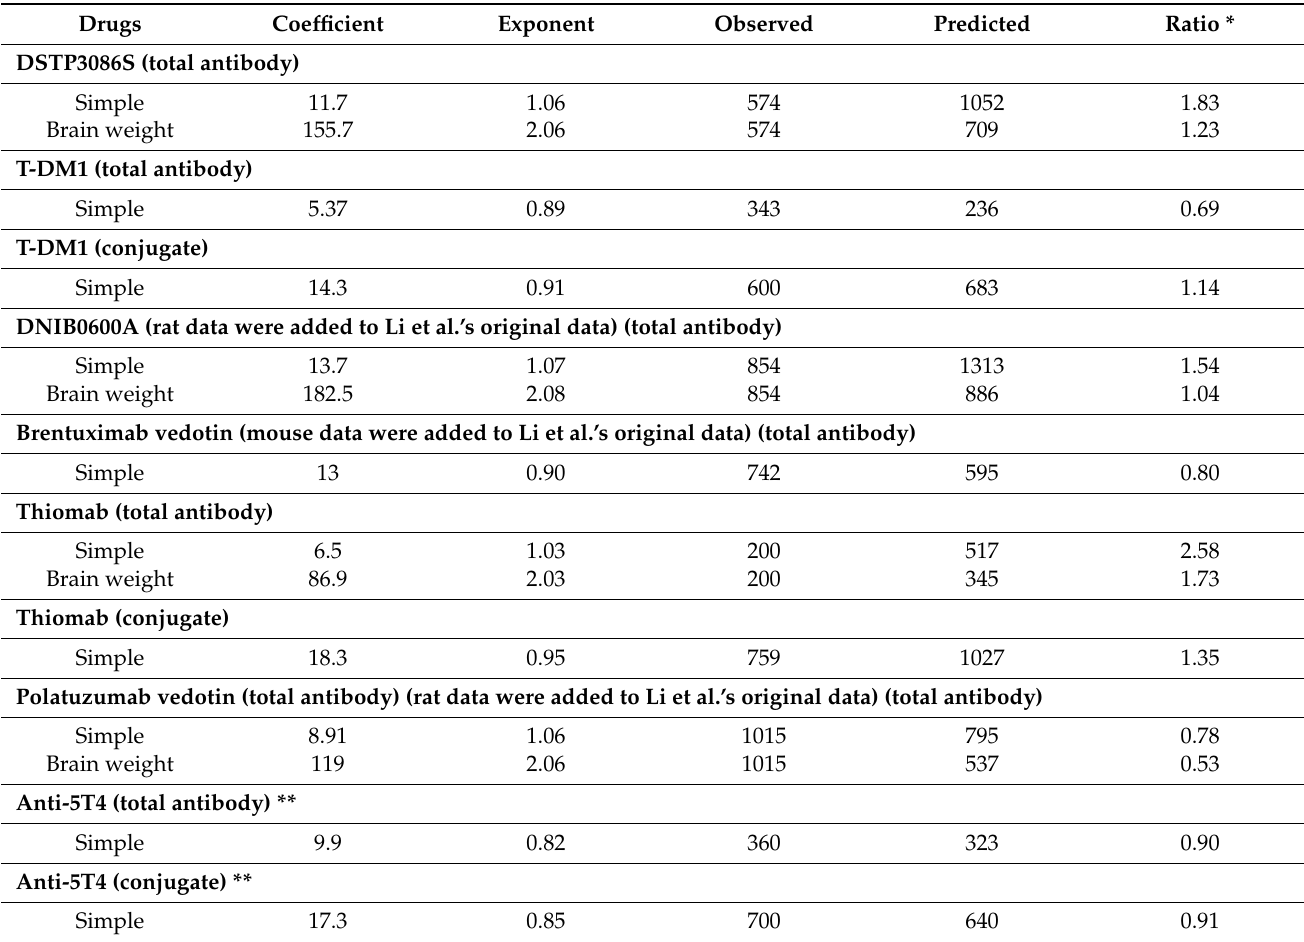
Table 2. Predicted and observed clearances of ADCs by three animal species allometric